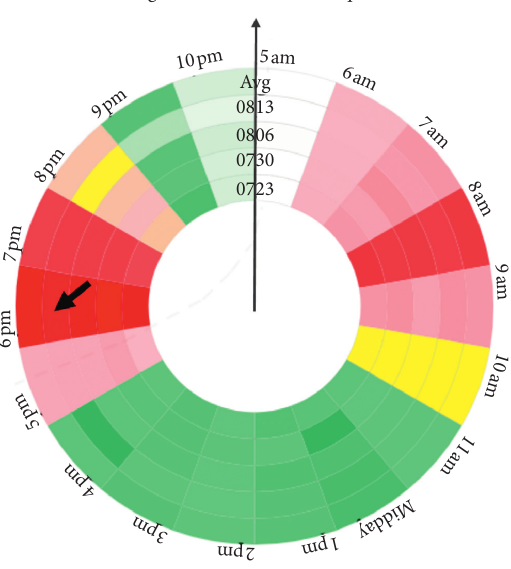
Figure 10: The changes of passenger flow at Xierqi station on August 13, 2015.